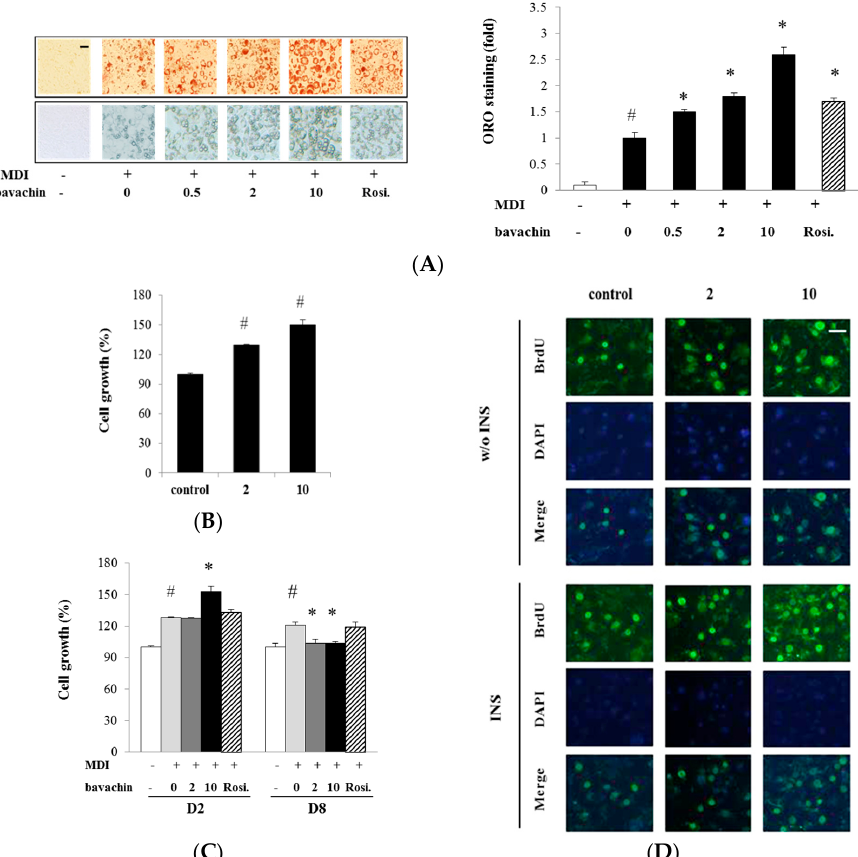
Figure 2. Effect of bavachin on proliferation and differentiation of adipocytes: ( A ) 3T3-L1 cells were differentiated with 0.5, 2 and 10 µM bavachin. Lipid accumulation was quantified by measuring absorbance of ORO staining. Images of adipocytes stained with ORO ( upper panel, magnification, 40×) and differentiated adipocytes ( lower panel, magnification, 100×) were visualized by light microscopy. Scale bar = 50 μ m. Data are expressed as mean ± SD. # p < 0.001 vs. control; * p < 0.01 vs. MDI alone; ( B ) Effect of bavachin on the growth of pre-adipocyte. Pre-adipocytes were incubated with bavachin (2 and 10 µM) for 72 h, and cell viability was determined by MTT assay; ( C ) The pre-adipocytes incubated with bavachin (2 and 10 µM) in presence or absence of insulin (100 nM) were stained with BrdU. Immunofluorescence of BrdU-incorporated proliferating cells was visualized in green, and DAPI-labeled nuclei were seen as blue under light microscopy; ( D ) Cell growth of differentiated adipocytes was determined by MTT assay on differentiation Day 2 and 8 (D2 and D8). Scale bar = 200 μ m. Data are expressed as mean ± SD. # p < 0.01 vs. control; * p < 0.05 vs. MDI.